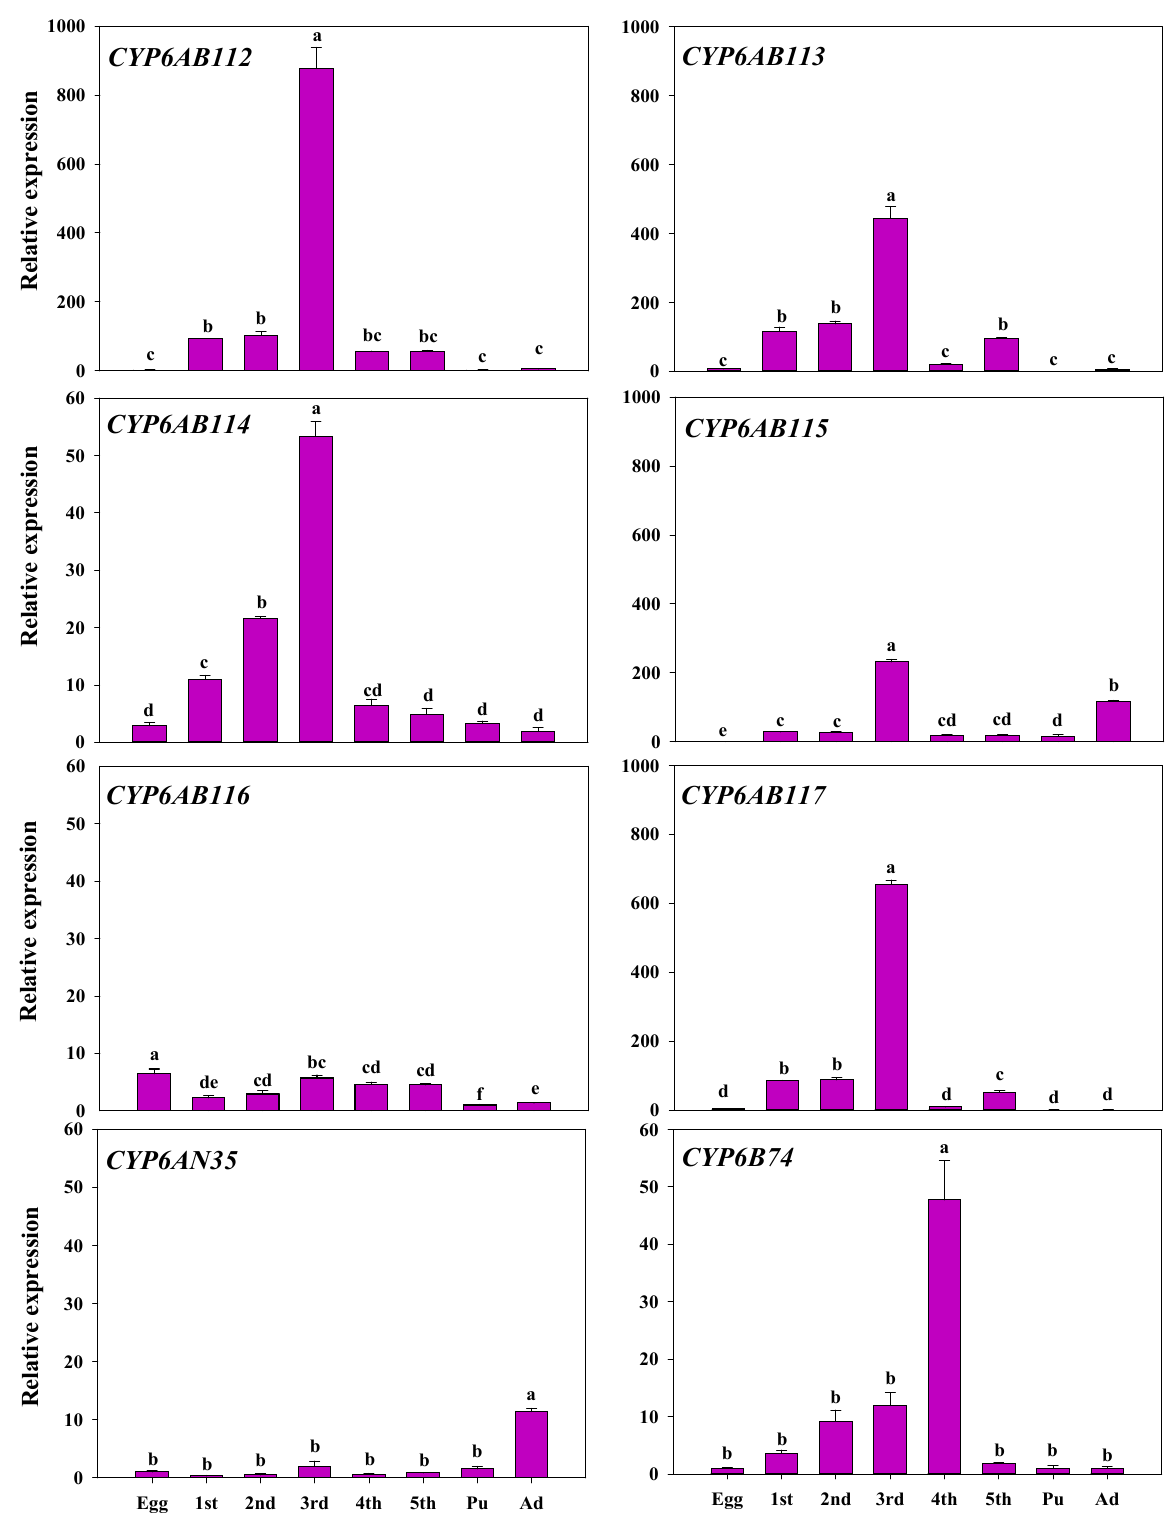
Figure 3. Expression of eight CYP6 genes at different developmental stages of G. molesta Note: egg (Egg), first-instar larvae (1st), second-instar larvae (2nd), third-instar larvae (3rd), fourth-instar larvae (4th), fifth-instar larvae (5th), pupae (Pu), and adults (Ad). Each treatment included three biological replicates. The data in the bar charts are presented as the means ± SEs. Different letters indicate significant differences at the p < 0.05 level, as determined by ANOVA and Tukey’s HSD test.